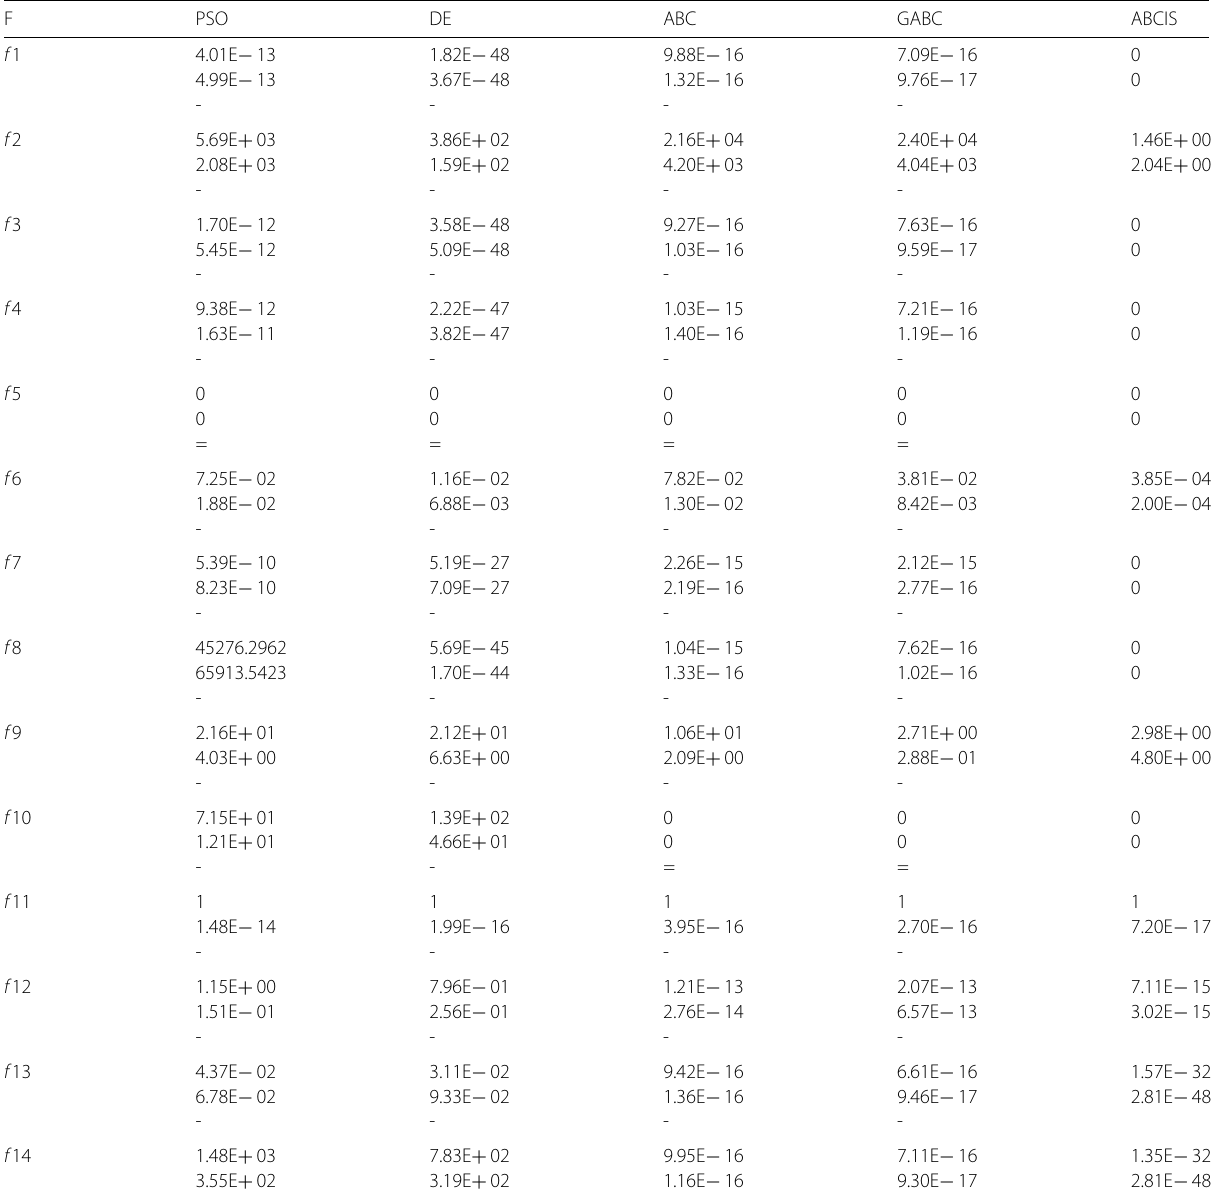
Table 4 Comparison results, D =